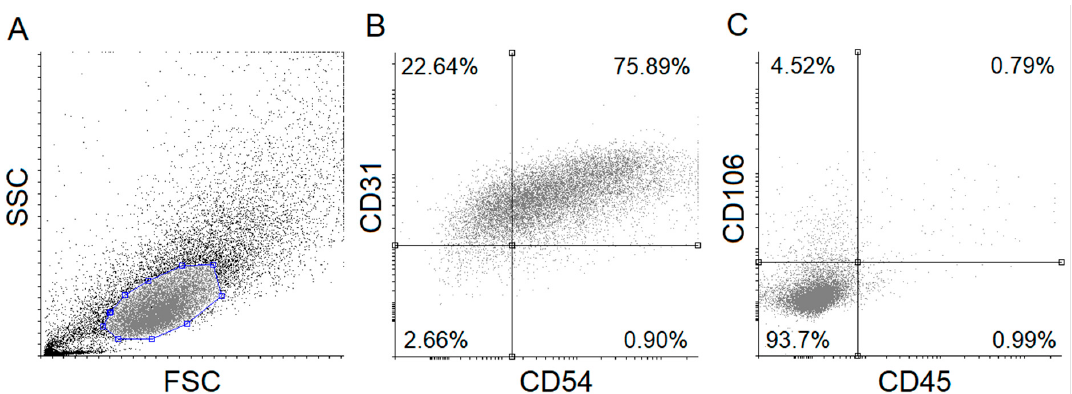
Figure 1. Flow cytometric analysis of human umbilical cord vein endothelial cells (HUVECs). Isolated HUVECs were verified using specific fluorescent-labeled antibodies. Forward- and side-scatter plot and dot-plots ( A ) of HUVEC positive (CD54, CD31) ( B ) and negative (CD45, CD106) ( C ) markers are shown. FSC: Forward scatter, SSC: Side scatter